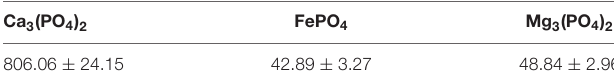
TABLE 4 | Phosphate solubilization by the JW-CZ2 strain.